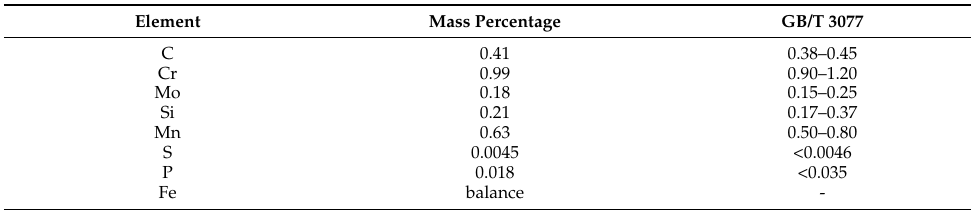
Table 1. Alloy steel composition of 42CrMo(wt.%).